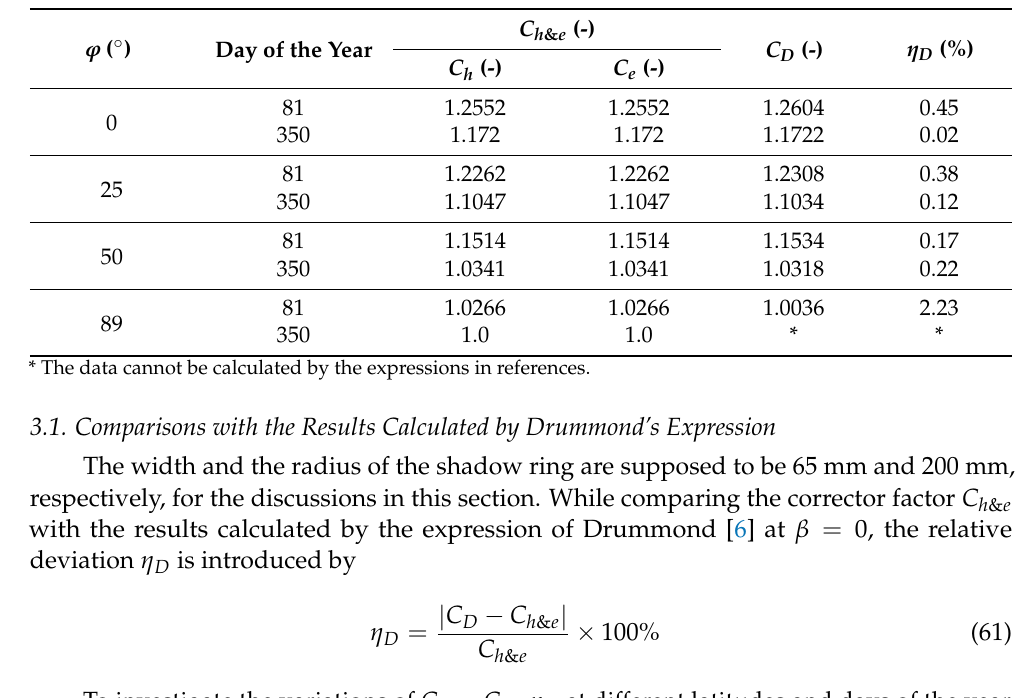
Figure 21. Surface chart of 𝐶 (cid:3005) varying with day of the year and different latitudes at 𝛽 = 0 . Figure 22. Surface chart of 𝜂 (cid:3005) varying with day of the year and different latitudes at 𝛽 = 0 . While the latitudes are in the Artic Circle, it can be found that the 𝐶 (cid:3035)&(cid:3032) is equal to 1.0 at some days in Table 1 and in Figure 20 when polar nights happen, however, 𝐶 (cid:3005) and 𝜂 (cid:3005) cannot be calculated in some days and the points in Table 1; in Figures 21 and 22 it is missing due to a reason that will be discussed in Section 3.3. For those 𝐶 (cid:3005) which can be